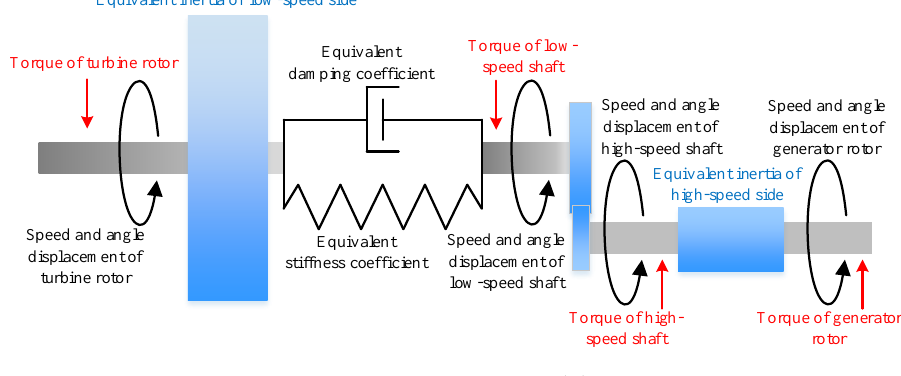
Figure 2. Two-mass model.